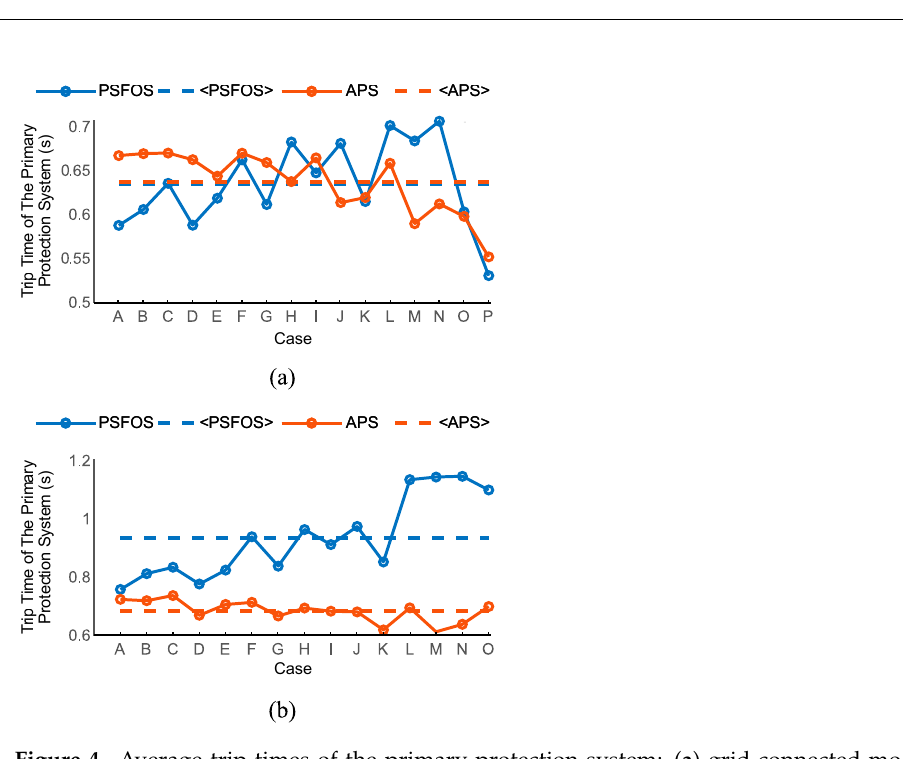
Figure 4. Average trip times of the primary protection system: ( a ) grid-connected mode, ( b ) islanded mode.